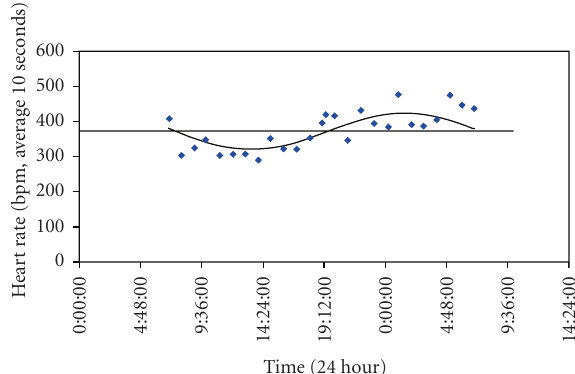
Figure 5: Example of fitted circadian rhythm in a representative rat for 24-hour heart rate post-Sham surgery. Cosinor analysis revealed significant periodicity ( P < . 05); with mesor = 372.2 (horizontal line above), amplitude = 51.6, acrophase = 1 : 28 hours. bpm =